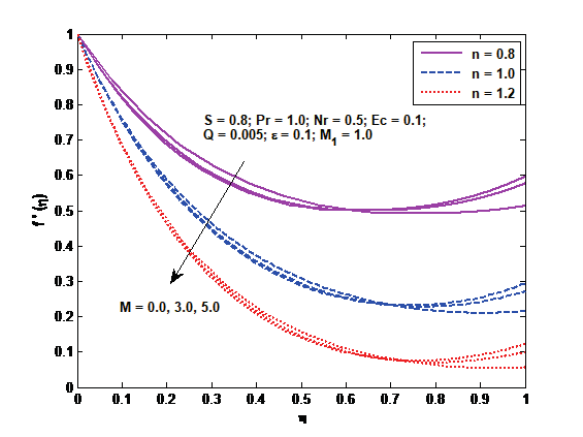
Fig. 5: Horizontal velocity profiles for different values of M